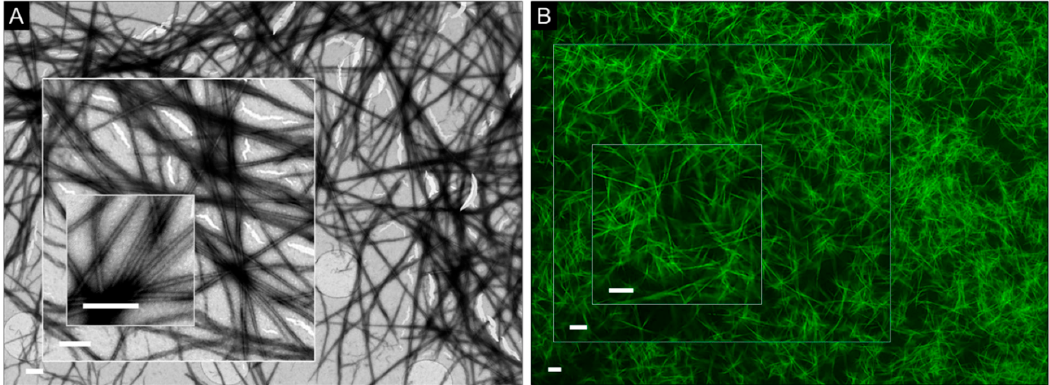
Figure 4. Effect of coating damage during imaging. ( A ) Electron micrograph of model 4 on Quantifoil ® grids coated with a single graphene layer (0.34 nm). ( B ) Fluorescent micrographs for model 4 assembled at the same conditions are given for visual comparison. Scale bars are 0.8 μ m ( A ) and 5 μ m ( B ). Staining conditions: ( A ) uranyl acetate (aq. 2%, w/v). The same imaging constrains hold true for spheroid or shell ‐ like protein assemblies. Substrate